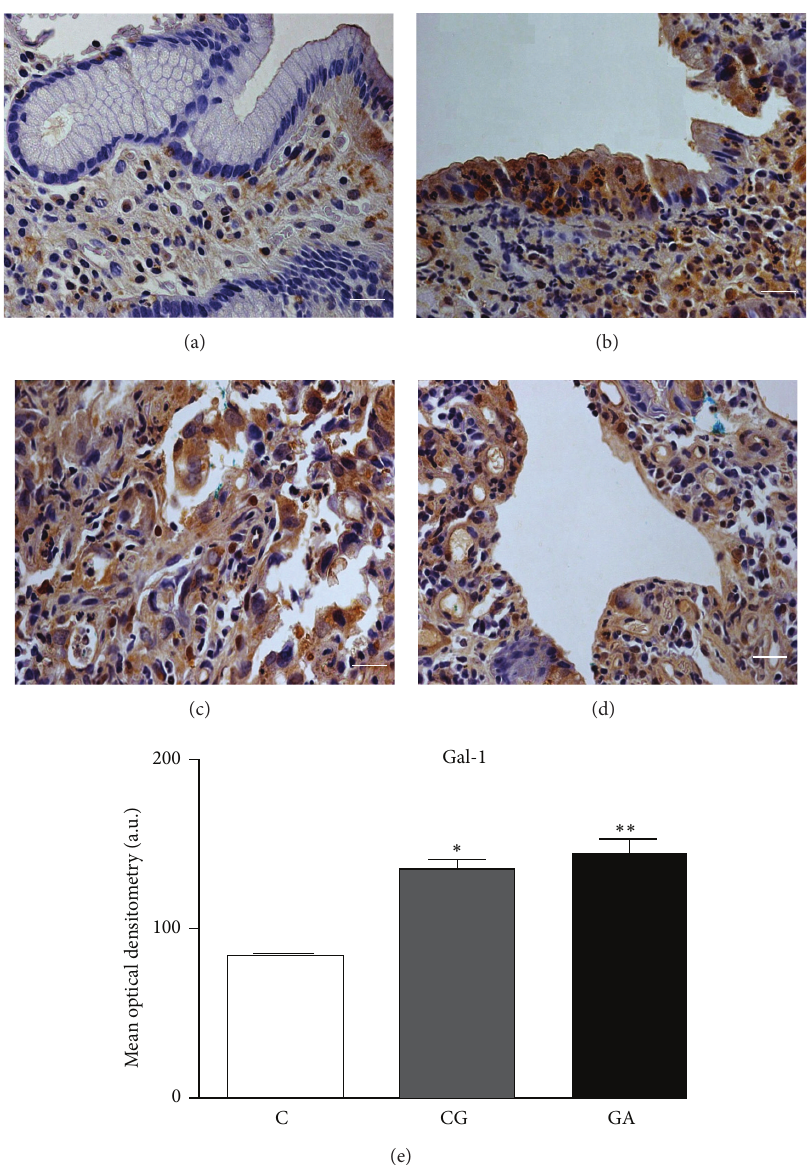
Figure 3: Endogenous galectin 1 (Gal-1) expression in the gastric mucosa. Immunoreactivity of Gal-1 in sections of gastric mucosa tissue by rabbit polyclonal anti-Gal-1. (a) Negative immunostaining in epithelium and modest positivity in stroma in normal mucosa. Immunopositivity in basal portion of epithelial in chronic gastritis (b) and, intense stromal-epithelial immunostaining in diffuse-type adenocarcinoma (c) and intestinal-type adenocarcinoma (d). Hematoxylin counterstain. Bar: 20 𝜇 m. (e) Densitometry analyses on the gastric mucosa tissues immunostained for Gal-1 in normal mucosa (C), chronic gastritis (CG), and gastric adenocarcinoma (GA) groups. Comparison between the C group and the CG ( ∗ ) and GA ( ∗∗ ) groups was made by the ANOVA test, with 𝑃 < 0.01 .